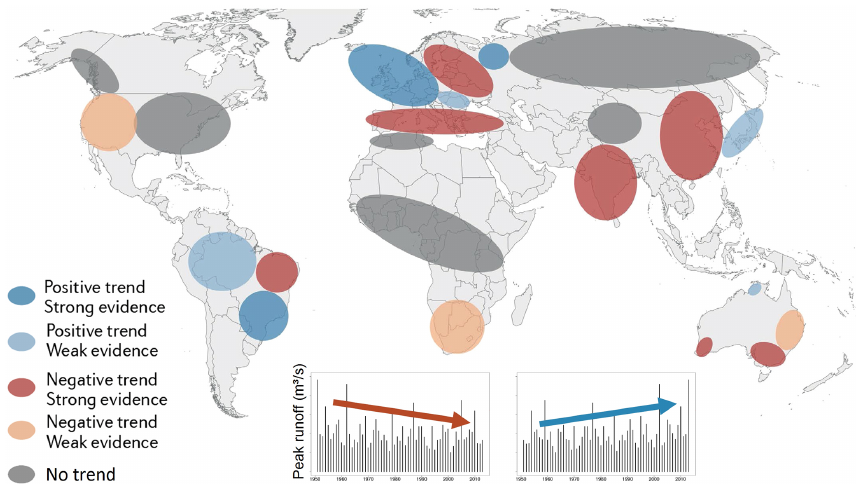
Figure 11. Observed flood trends in the period of approximately 1960–2010 based on the analysis of runoff data. Blue colours indicate an increasing trend, reddish colours show a decreasing trend in mean flood peak runoff. The patterns are based on a literature meta-analysis. Globally, there are both increasing and decreasing trends of flood hazards. Merz et al.